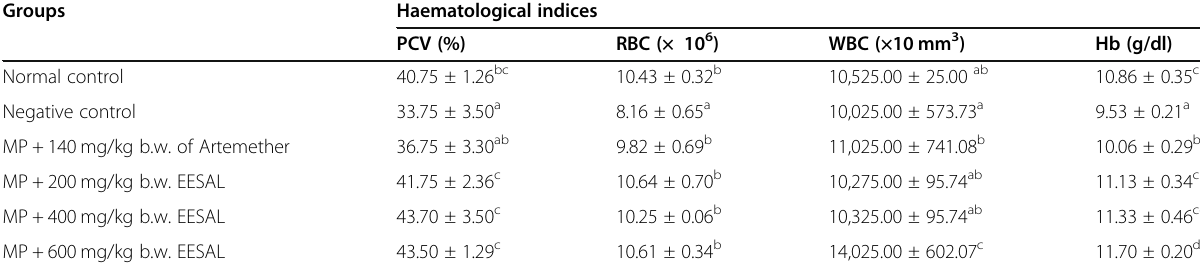
Table 4 Effect of the EESAL on some haematological indices in Plasmodium berghei -infected mice Groups